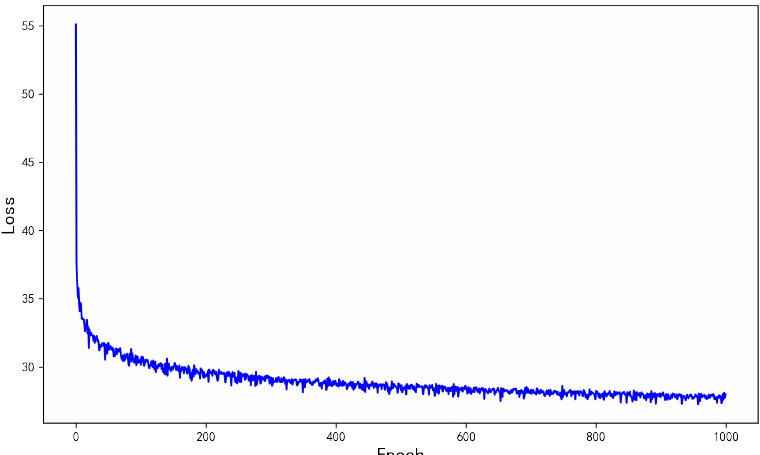
Figure 5. Training process for Estate dataset when learning the rate is 0.005.